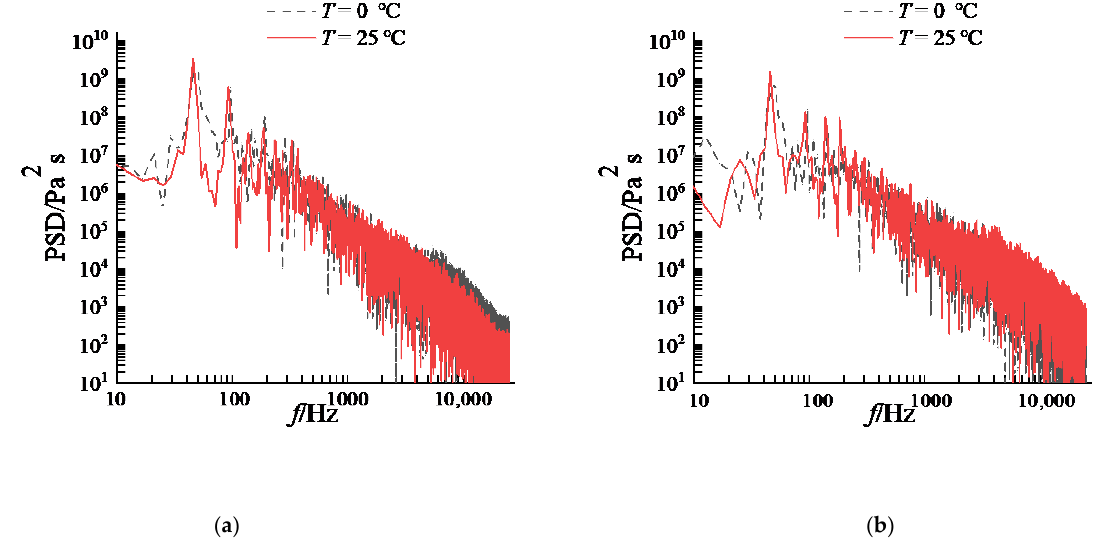
Figure 10. Comparison of power spectral density (PSD) corresponding to natural cavitation pressure pulsation at points P1 ( a ) and P3 ( b ) at two temperatures.